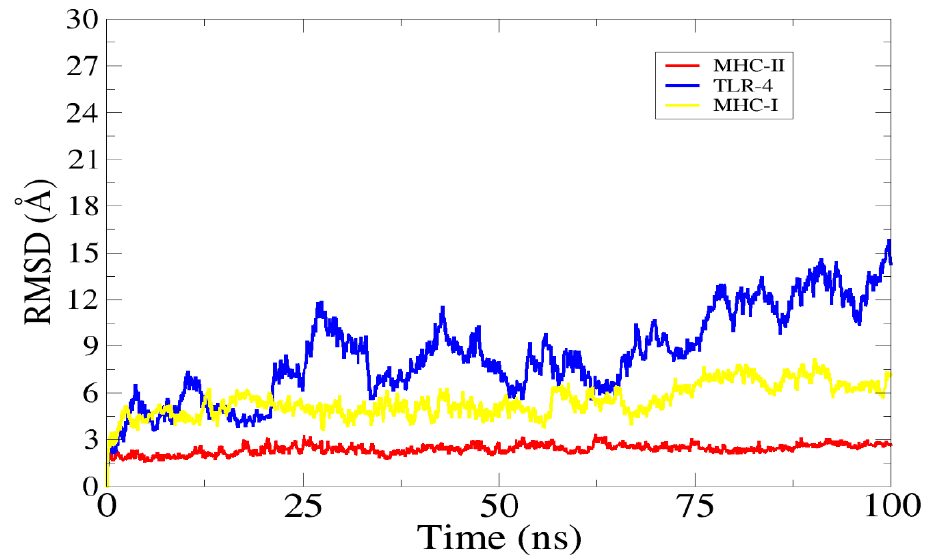
Figure 9. The root-mean-square deviation (RMSD) analysis graph.